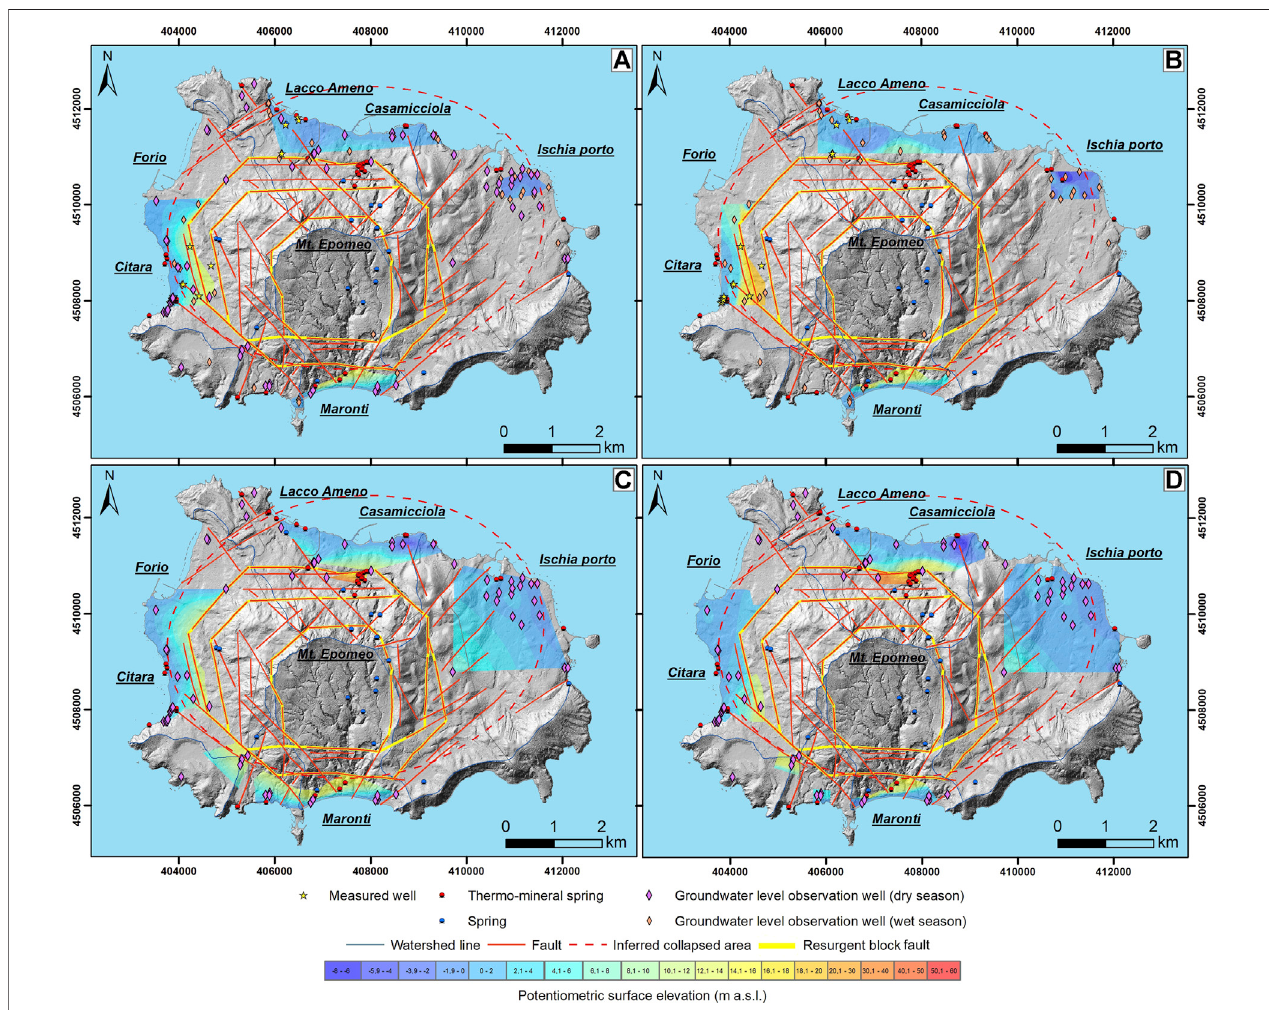
FIGURE 10 | Structural sketch map of Ischia Island and reconstructed piezometric surfaces of the four main geothermal areas: (A) NaN interpolation (dry season); (B) IDW interpolation (dry season); (C) NaN interpolation (wet season); (D) IDW interpolation (wet season).The geometry of datasets used for the interpolation is shown; the location of wells used for the validation is reported, as well as all springs/thermo-mineral springs surveyed during fi eld activities. DEM details are in Figure 2 .